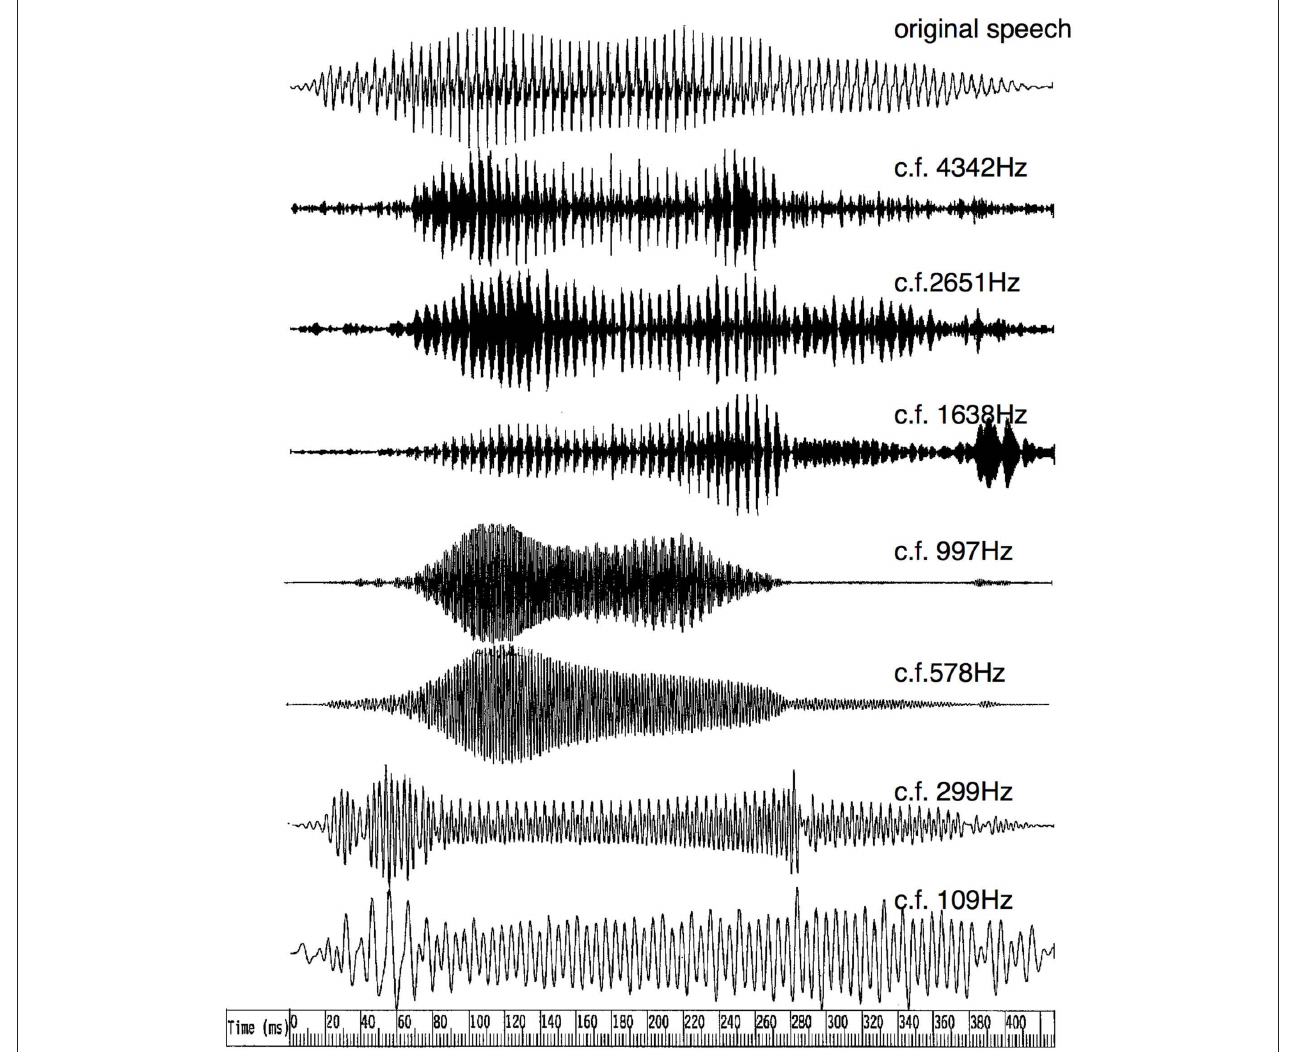
Figure 1 | Oscillograms of the word “one” spoken by female speaker, and the output of a gammatone filterbank when this signal is passed through (number of channels = 7, erB = 4.0). The rise times within the different bands of spectral energy differs both in rate of change and where the big changes in rise time